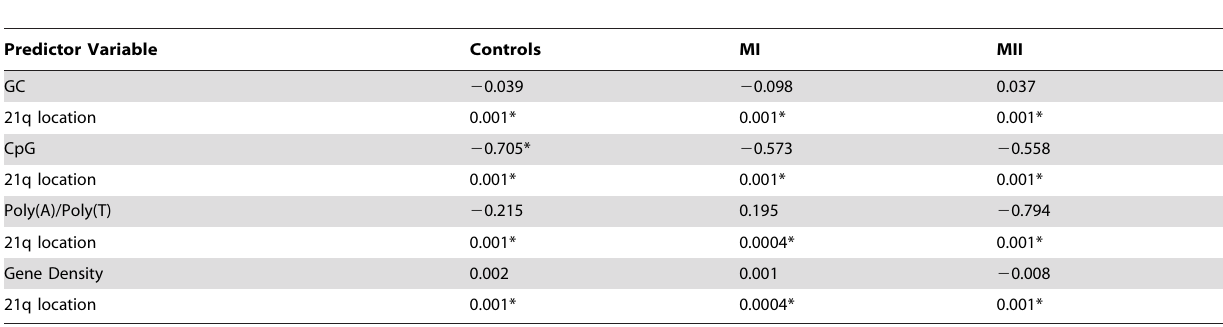
Table 4. Values of slopes/beta coefficients for GC, CpG, Poly(A)/Poly(T) and gene density for the distal recombinant of a double recombinant event stratified by meiotic outcome